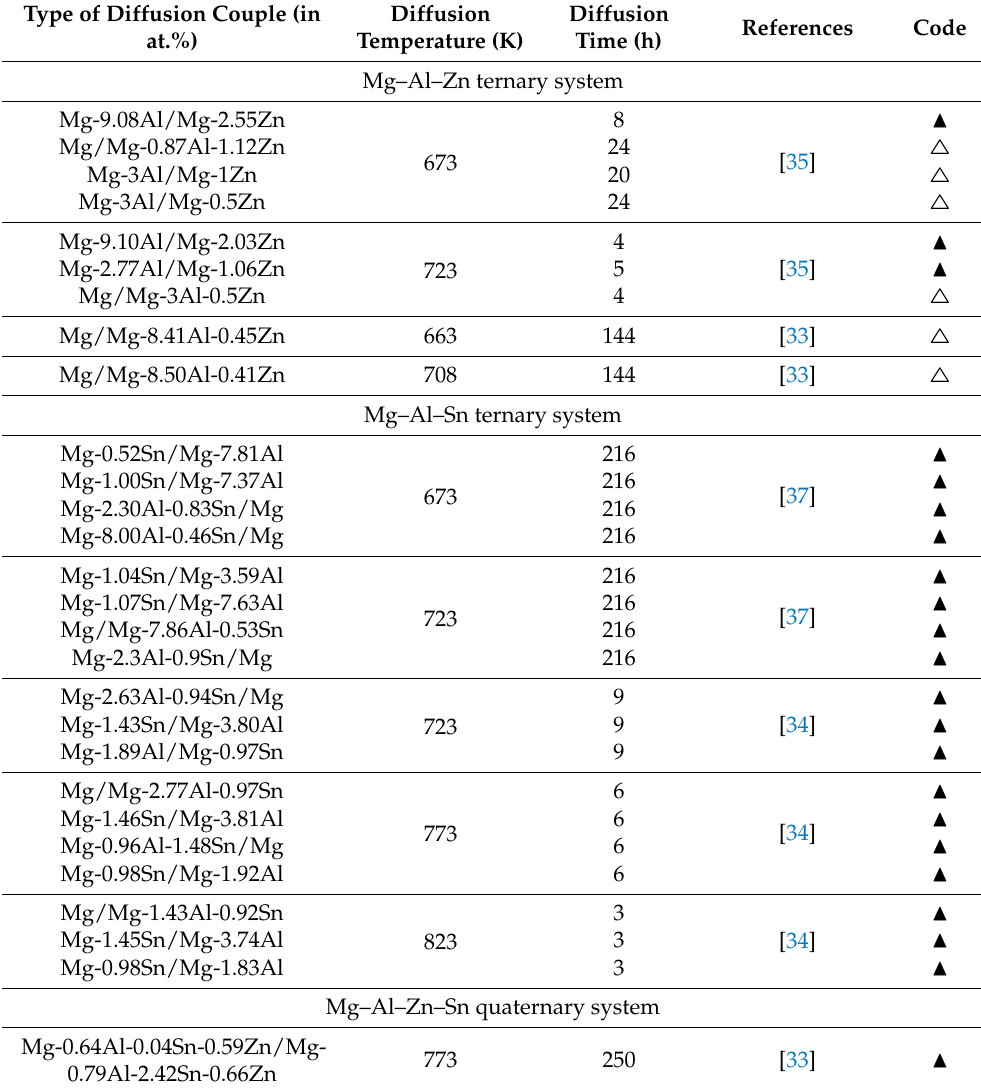
Table 1. List of the composition–distance profiles of different hcp_A3 Mg–Al–Zn, Mg–Al–Sn, and Mg–Al–Zn–Sn alloys available in the